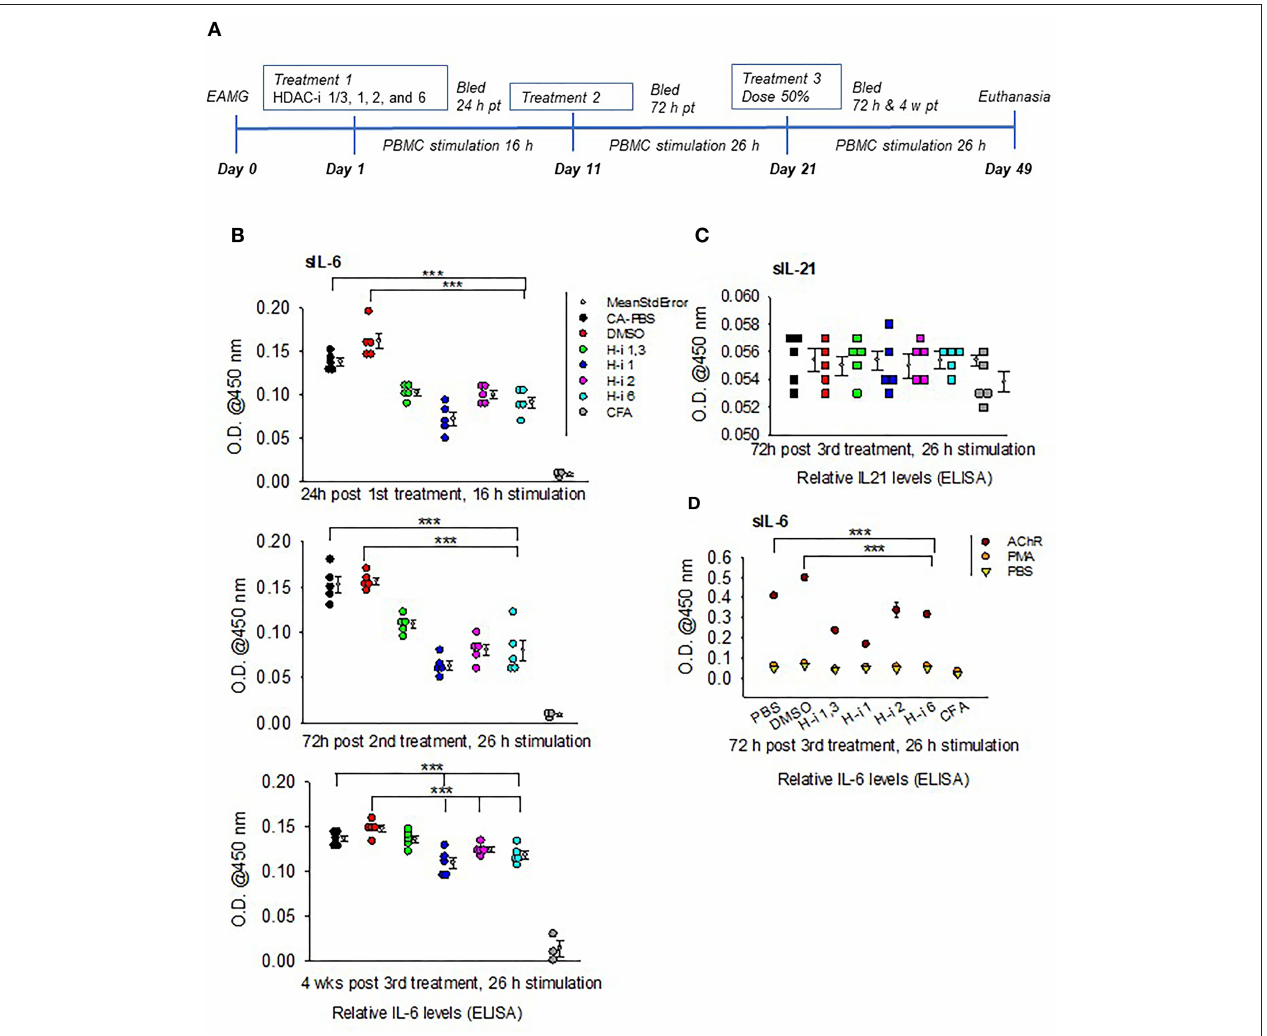
FIGURE 1 | Relative levels of secreted IL-6 and IL-21 in the supernatants of AChR-stimulated PBMCs. (A) Treatment schematic of EAMG model (grade 2) with HDAC inhibitors (HDAC-i). (B) Relative IL-6 levels in the supernatant upon stimulation of PBMCs with AChR at the indicated post treatment time points. (C) Relative IL-21 levels in the supernatant of AChR-stimulated (26h) PBMCs from EAMG mice treated or not with HDAC-i. (D) Relative levels of IL-6 secreted from PBMCs stimulated for 26h with specific (AChR) or nonspecific stimulus (PMA/ionomycin) or no stimulus (PBS-only). PBMCs were isolated 72h later from untreated EAMG mice or EAMG mice treated with HDAC-i (post 3rd treatment). Each dot represents mean + /- standard deviation; readings are from triplicate microplate wells belonging to the same group of pooled supernatant samples. CFA ( n = 3) and each EAMG ( n = 5 per group). *** P < 0.001, ANOVA. The experiment is representative of three similar